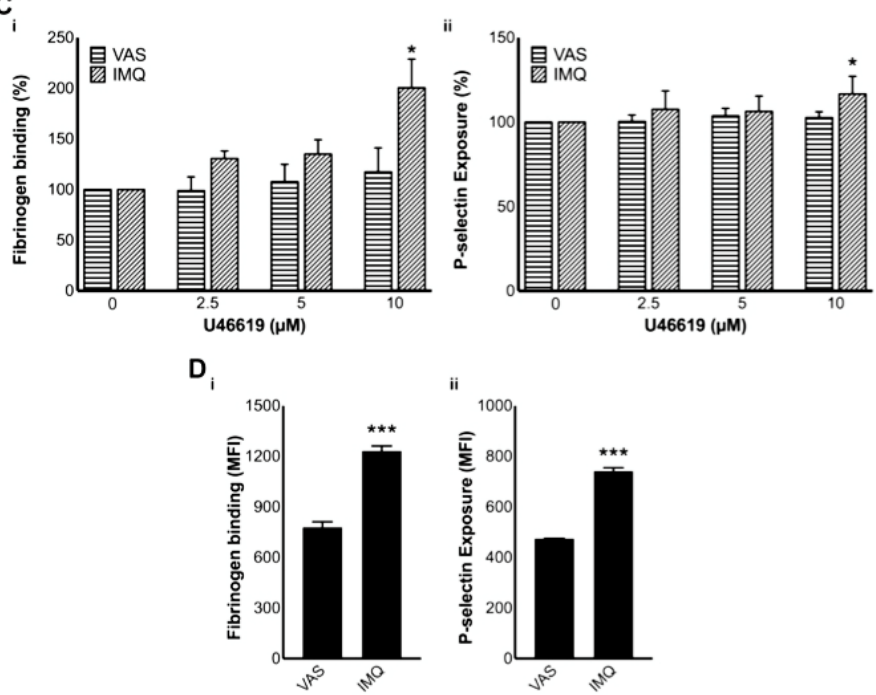
Figure 2. The activation of platelets during psoriasis. The activation of platelets upon stimulation with CRP-XL ( n = 3) ( A ), ADP ( n = 4) ( B ), U46619 ( n = 3) ( C ), or resting platelets ( n = 4) ( D ) in whole blood obtained from IMQ-treated and control mice was analysed by measuring the level of fibrinogen binding (i) and P-selectin exposure (ii) by flow cytometry (by collecting 5000 events within a gated region for platelets). In ( A – C ), the MFI obtained for Vaseline-treated mouse platelets at 0 µ M was taken as 100% to normalise the data for easier comparison. p values shown are as calculated by two-way ANOVA followed by Bonferroni’s post-hoc test except for the data in ( D ) where a two-tailed unpaired Student’s t -test was used (* p < 0.05, and *** p < 0.0001).